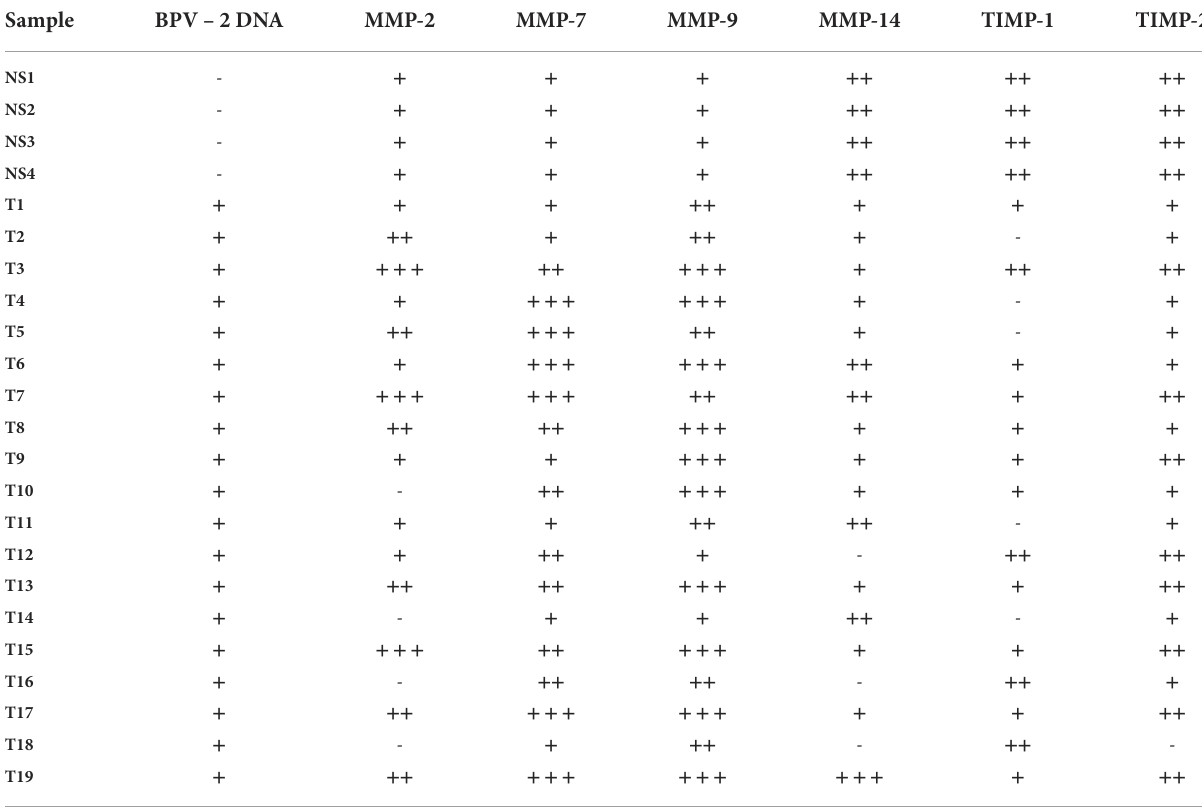
TABLE 2 Immunoreactivity scoring of MMP-2, MMP-7, MMP-9, MMP-14, TIMP-1, and TIMP-2 in bovine normal skin and fibropapilloma